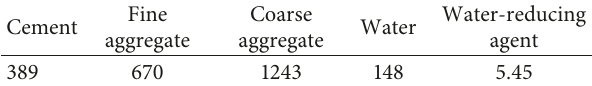
Table 1: Mix proportion of cement concrete (kg/m 3 ).